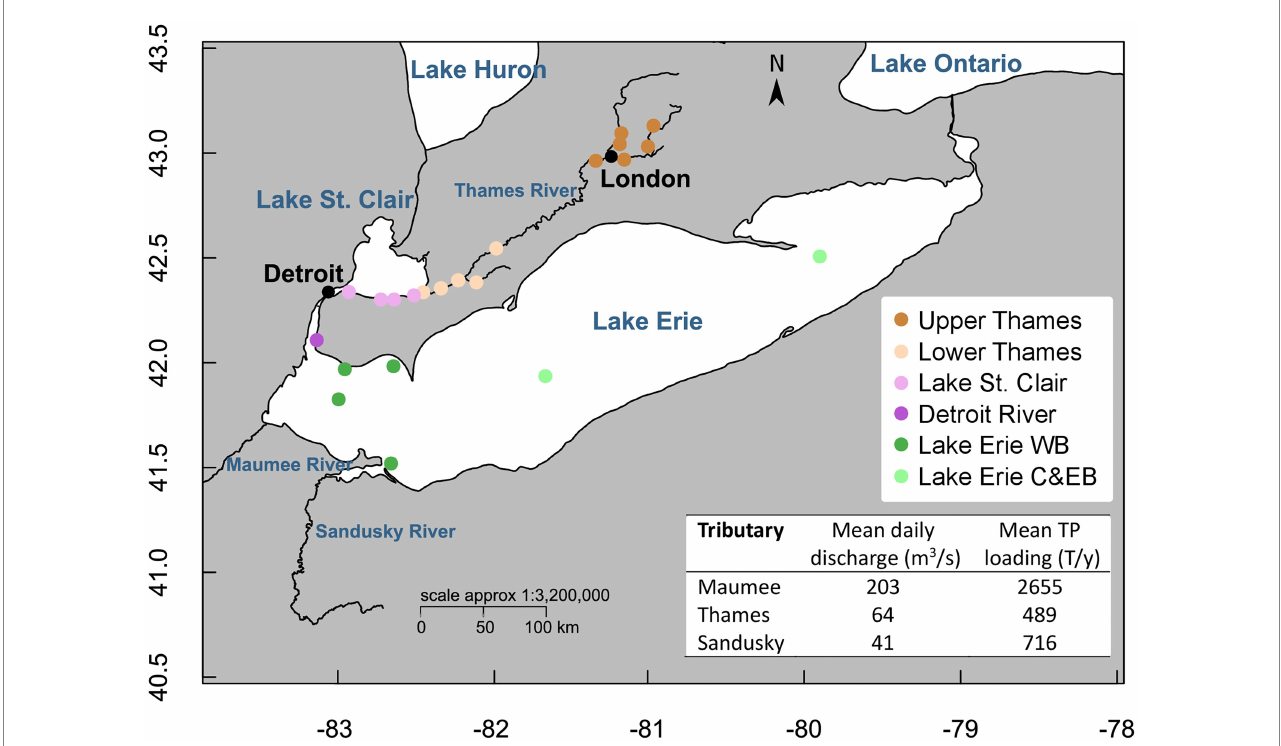
FIGURE 1 Location of the sampling sites colored by systems (Upper and Lower Thames Rivers, Lake St. Clair, Detroit River and Lake Erie). Map created with R using the open-access databases “worldHires” (https://www.evl.uic.edu/pape/data/WDB/) and river line downloaded from the Government of Canada Open Data Portal (http://open.canada.ca/en/open-data) and the National Weather service (https://www.weather.gov/gis/Rivers). Estimates of mean daily discharge from 2016 to 2019 were calculated from data available from the Water Survey of Canada (https://wateroffice.ec.gc.ca/) for the Thames River and from the U.S. National Water Information System (https://waterdata.usgs.gov/nwis) for the Maumee and Sandusky Rivers. Estimates of mean TP loads from 2016 to 2019 were calculated from the data available from ErieStat